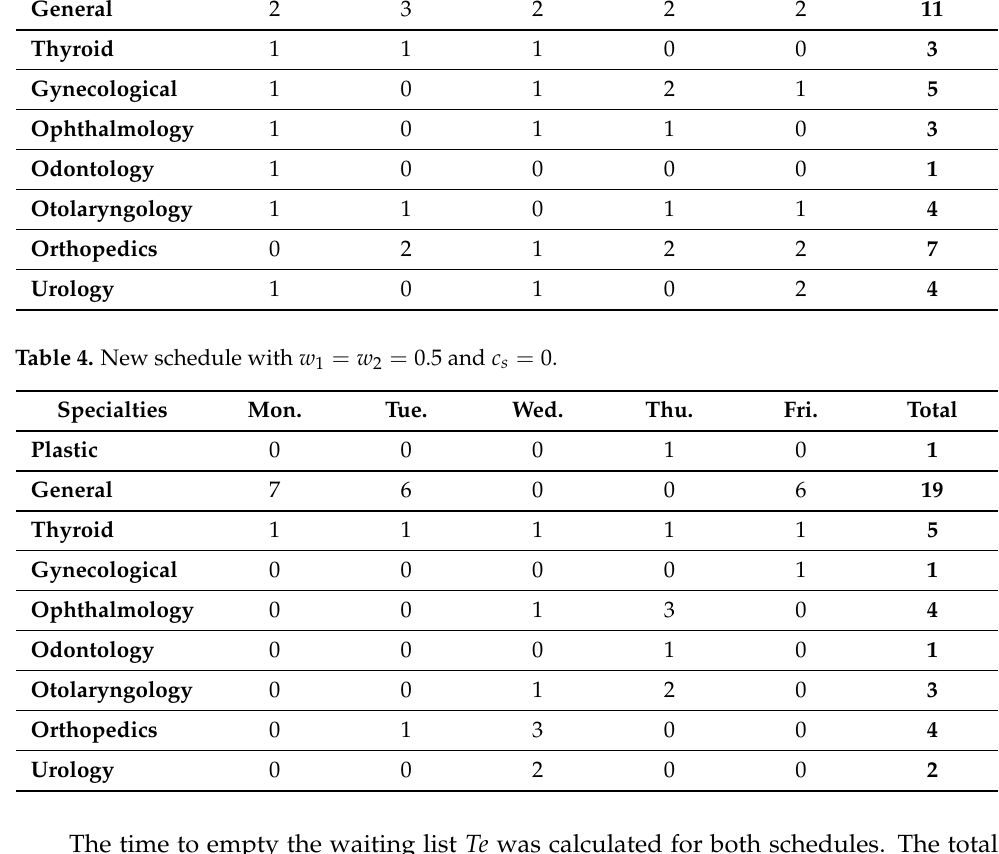
Table 3. Current schedule used in the studied Hospital. Specialties Mon. Tue.